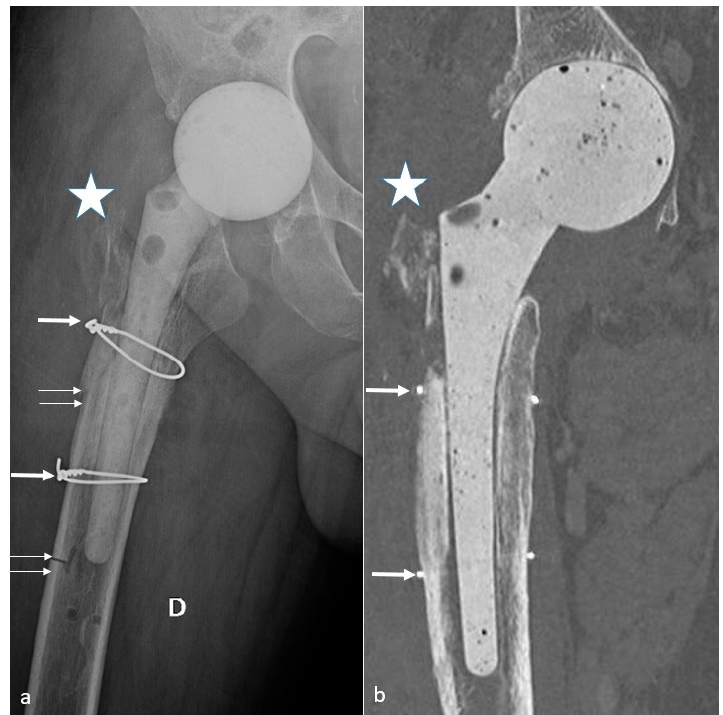
Figure 19. Spacer appearance. A spacer is shown on an AP radiograph ( a ) and a coronal CT-scan slice ( b ). Note the cerclage wires (thick arrows), the trochanteric lysis (white star), and the femorotomy sequelae (thin double arrows). NB: “D” in (a) means “droite” and is referred to the right